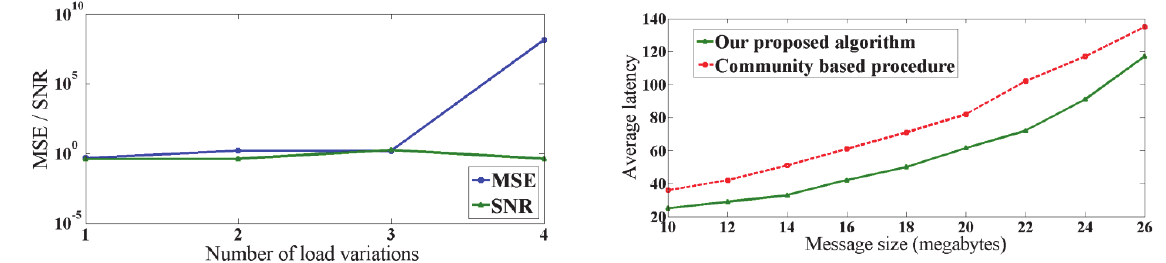
Fig. 7. Variance in MSE and SNR Fig. 8. Latency and message